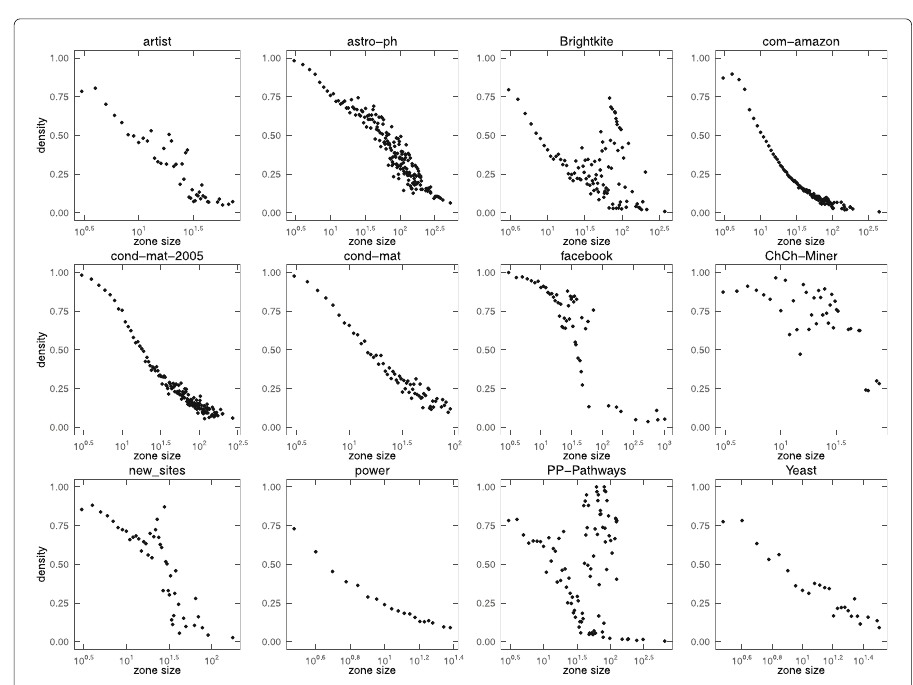
Fig. 25 Density of zones in real-world networks